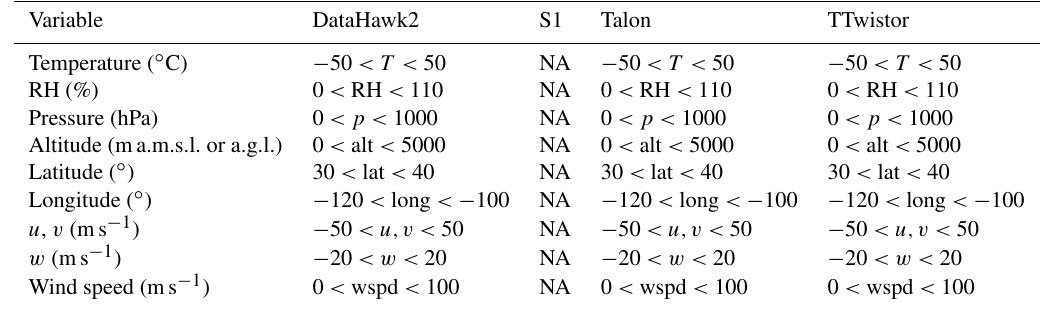
Table 2. Quality control limits applied to the different data b1 datasets. To date, S1 data are only available as a1 level files. Variable